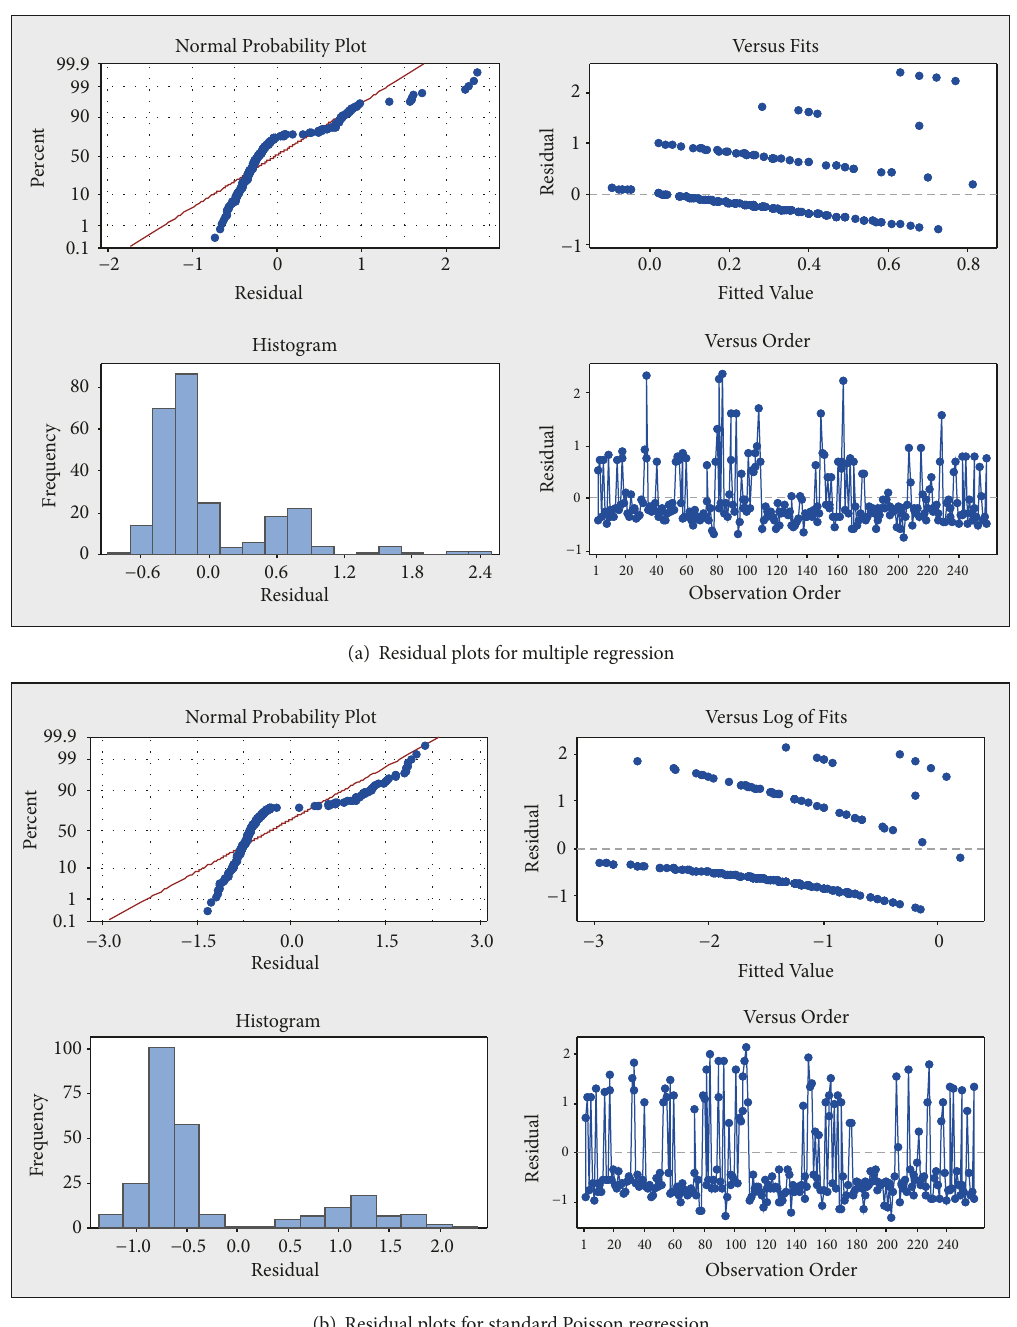
(b) Residual plots for standard Poisson regression Figure 2: (a) Residual plots for multiple regression and (b) for standard Poisson